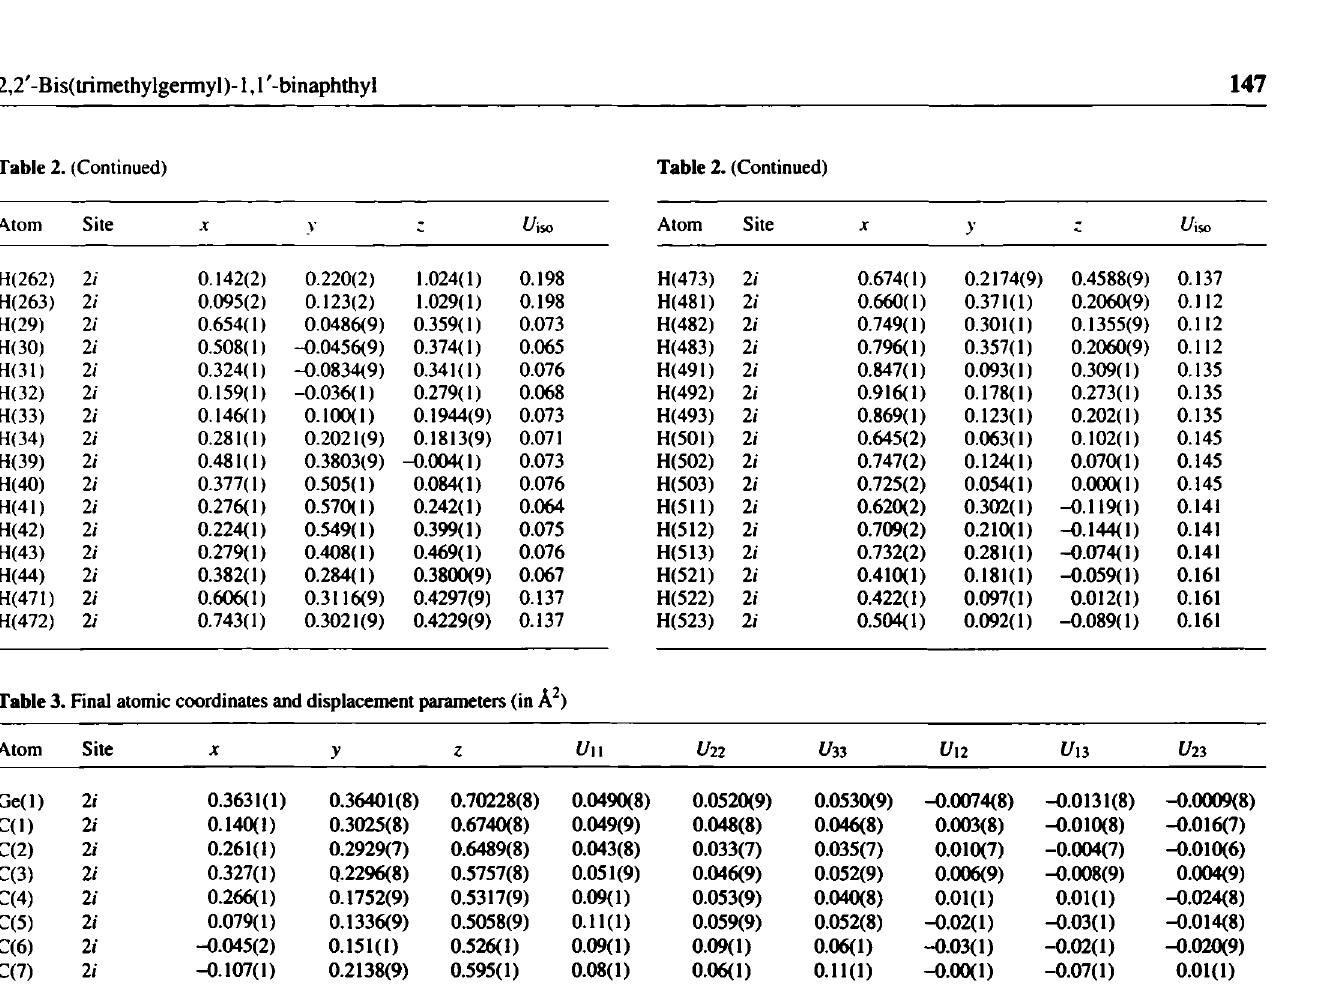
Table 3. Final atomic coordinates and displacement parameters (in Â 2